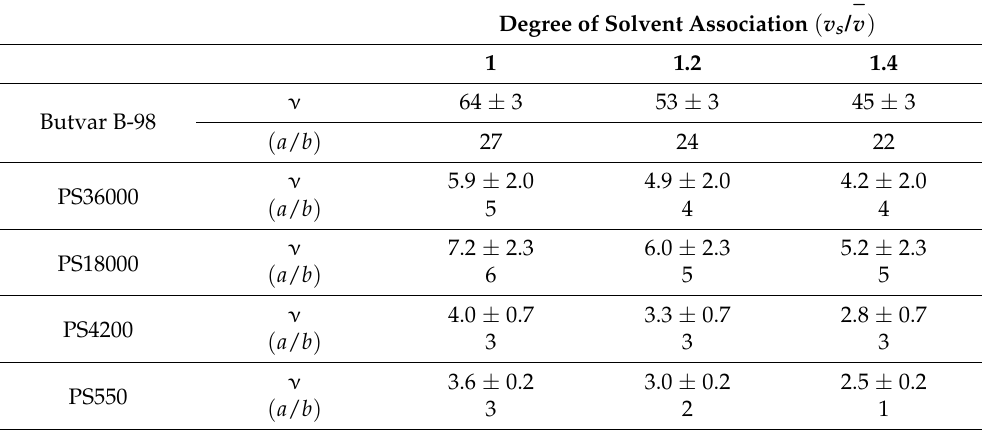
Table 3. Viscosity increment ν for different degrees of solvent association (dynamic binding)